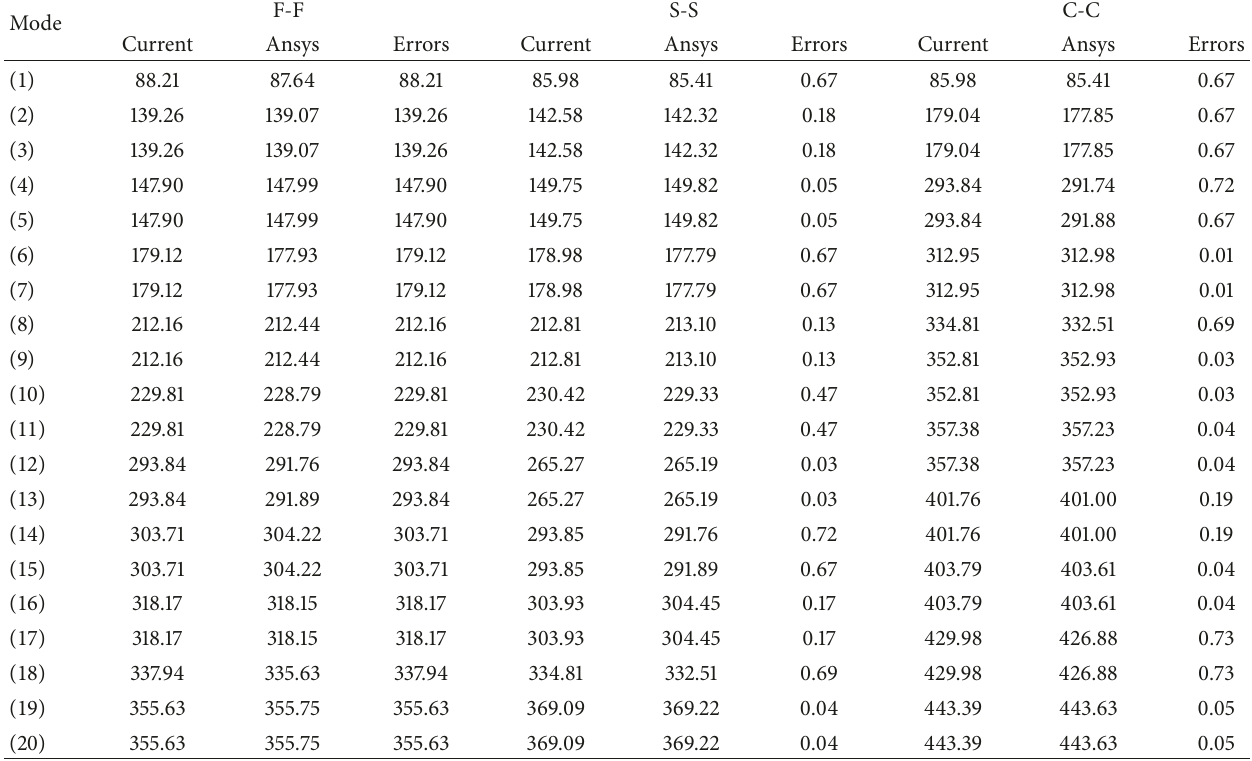
Table 2: The frequency for coupled structure with asymmetrical boundary condition 𝑓 /Hz.